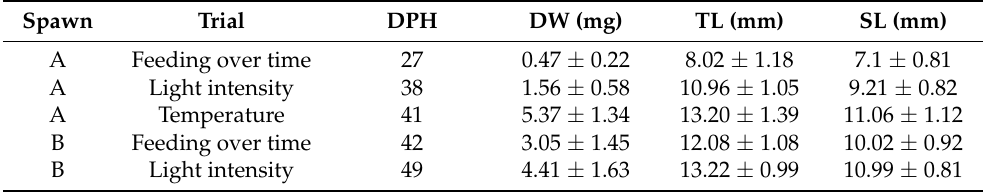
Table 1. Length and weight (mean ± standard deviation, n = 30) of Sparus aurata larvae used in the feeding, light intensity, and temperature experimental trials.